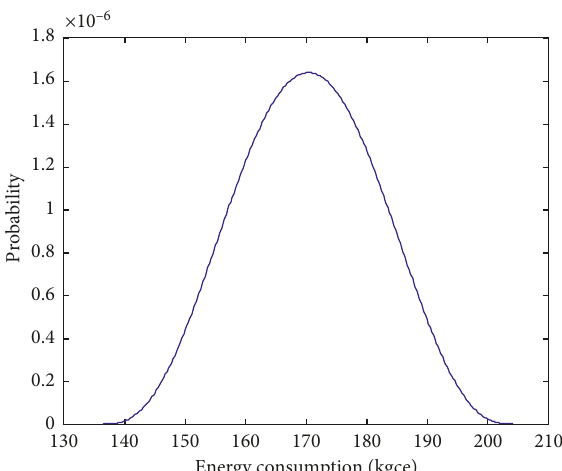
Figure 2: Probability density function of base asphalt production energy